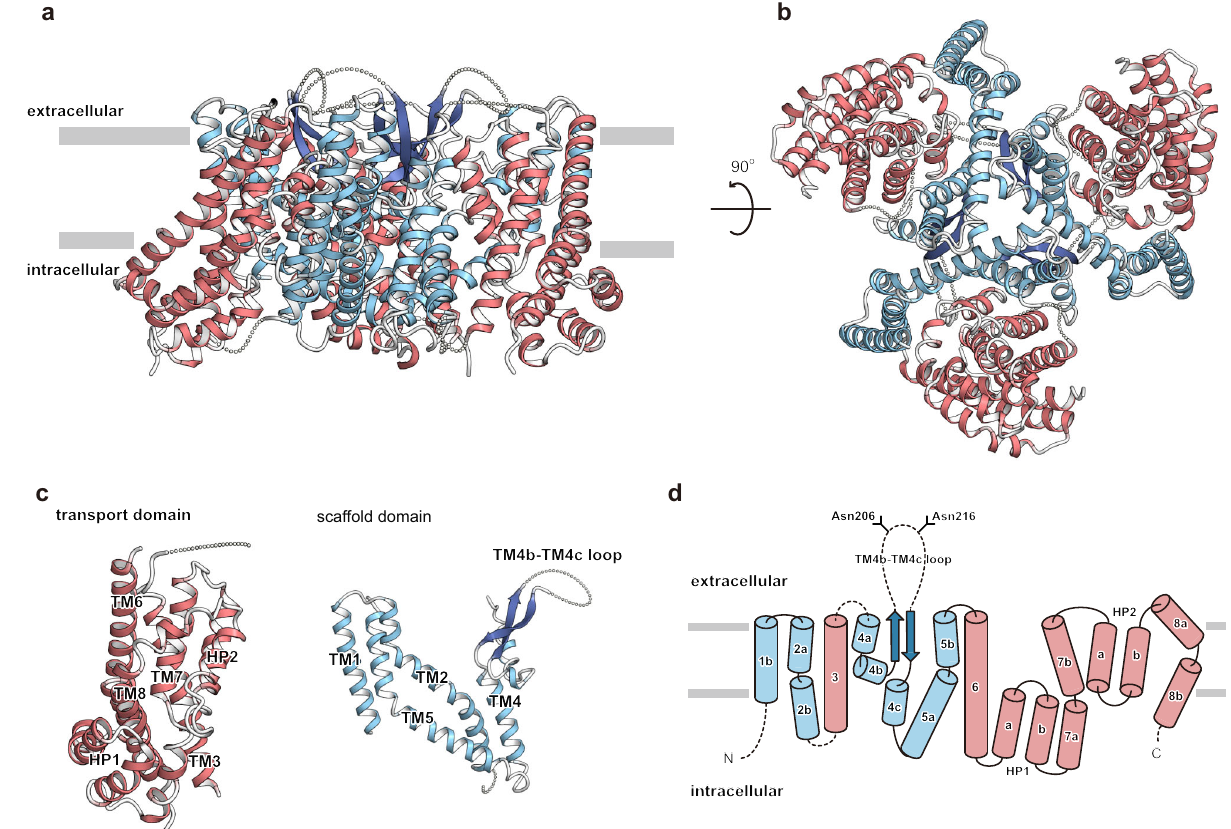
Fig.1|OverallstructureofHsEAAT2.a , b OverallstructureofHsEAAT2,asviewed from a themembraneplaneand b theintracellularside. c Thescaffolddomainand the transport domain in one protomer are labeled. d Topology diagram of